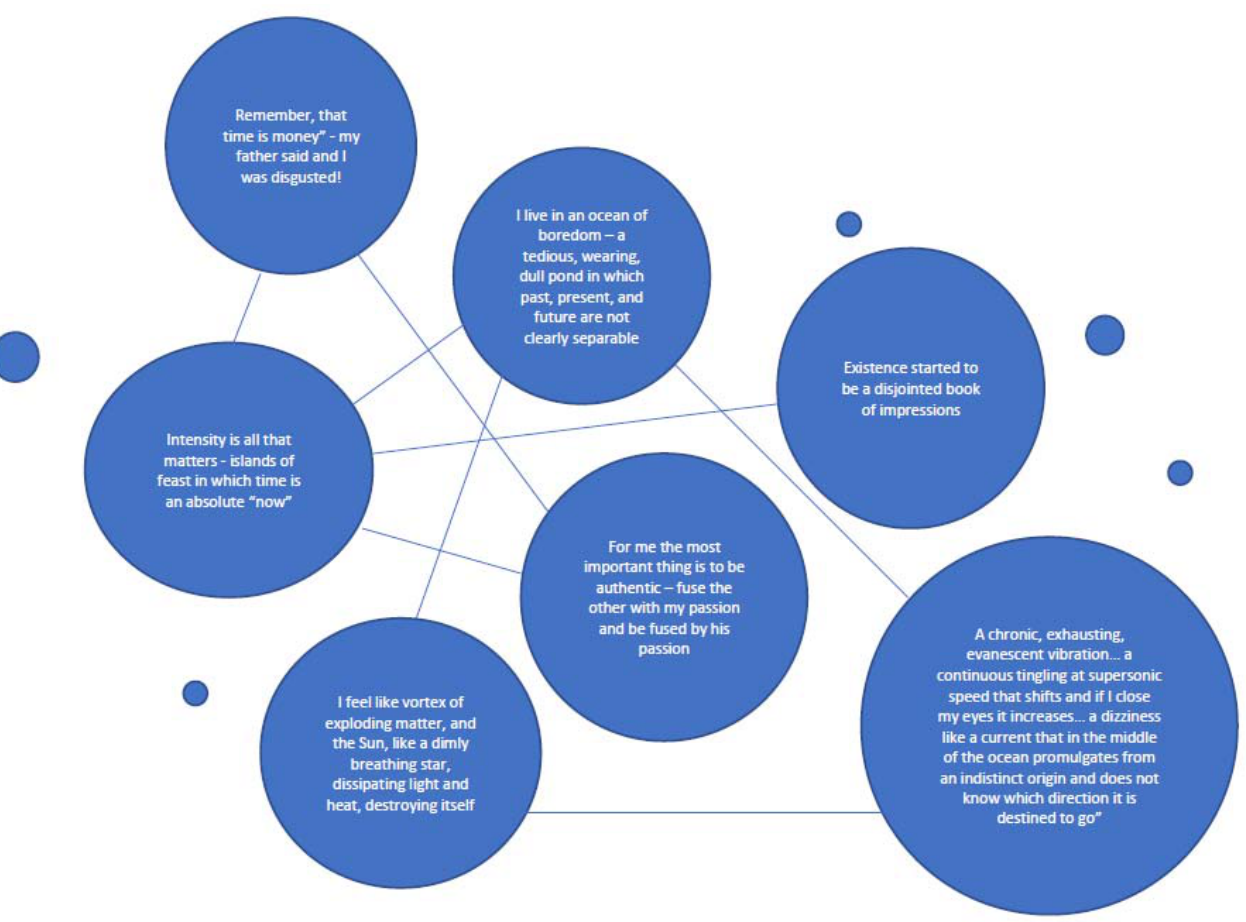
Figure 2. Linking dots. Images from a dissipating style of existence.